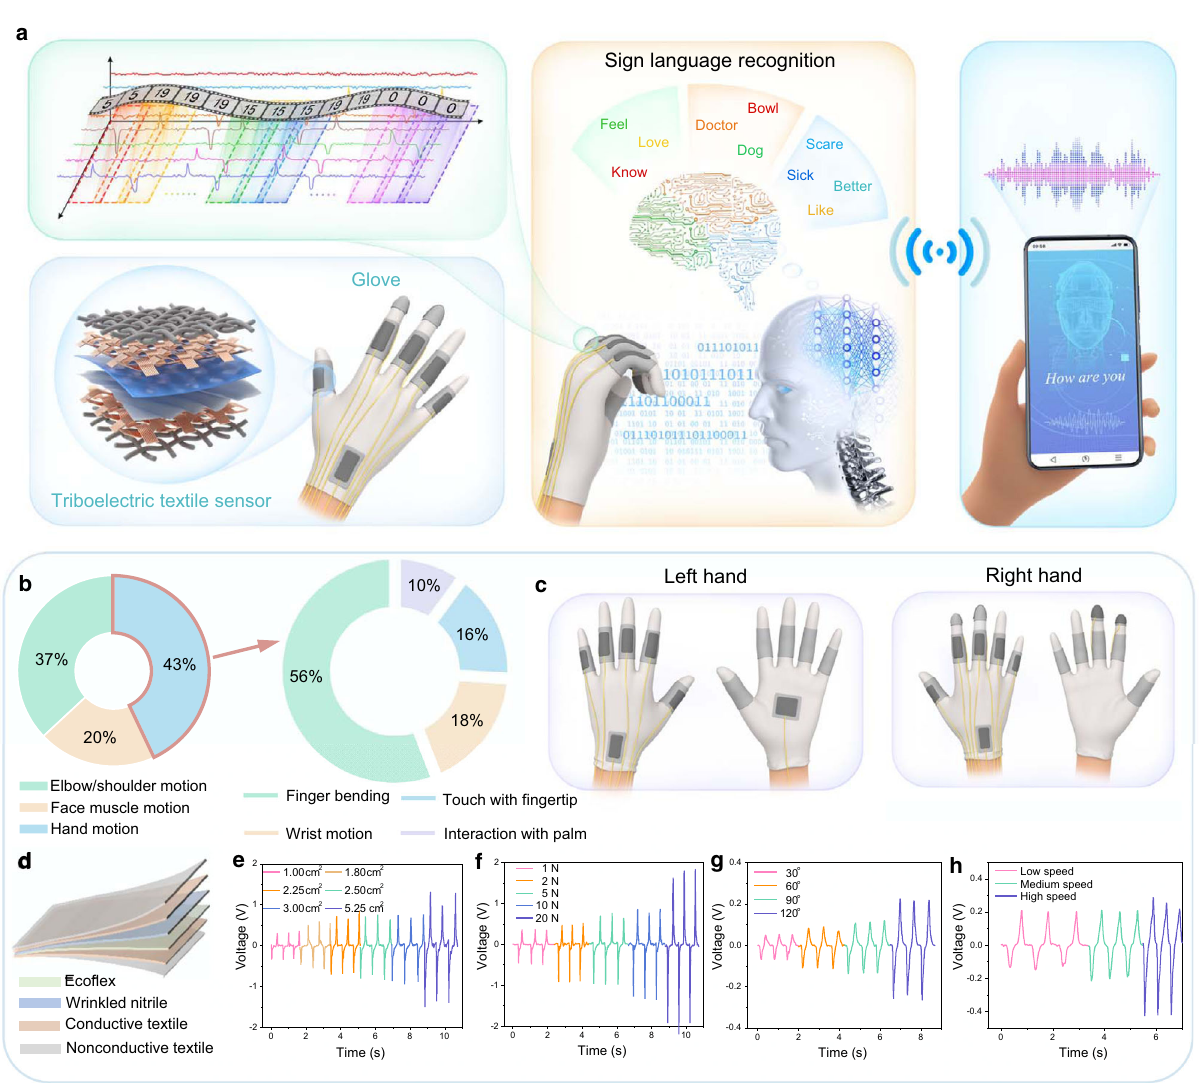
Fig. 1 The glove con fi guration and sensor characterization. a Schematics of the sign language recognition and communication system. b Proportion of different motions that are commonly used in sign language helps determine sensor position on gloves. c Sensor position on gloves based on hand motion analysis in b . Detailed area information of the sensor on each position can be found in Supplementary Fig. 1. d Materials of the triboelectric sensor. e – h Voltage output dependence on key parameters, including sensor area, force, bending degree, and bending speed. The hand, head, and phone images are created by the authors via